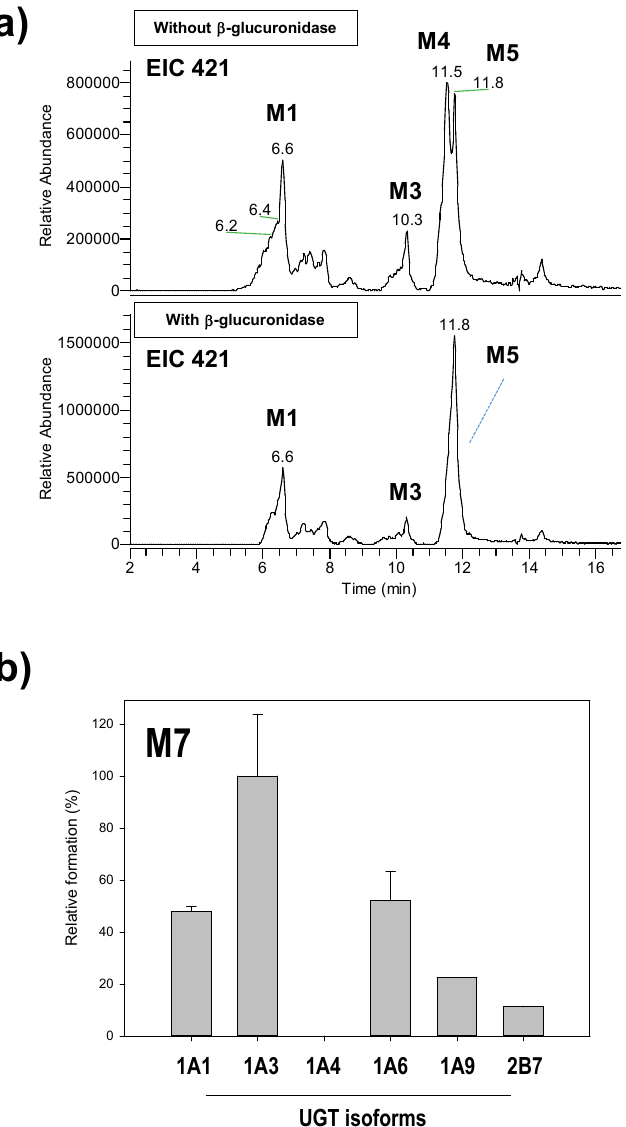
Figure 5. The formation of M7 in human liver microsomes (HLMs). Extracted ion chromatograms for M7 after incubation for 60 min with 1 mg/mL HLMs in the absence and the presence of β-glucuronidase ( a ) and the formation of M7 from M5 in human recombinant cDNA-expressed uridine 5′-diphospho-glucuronosyltransferase (UGT) isoforms ( b ) after treatment with β-glucuronidase.